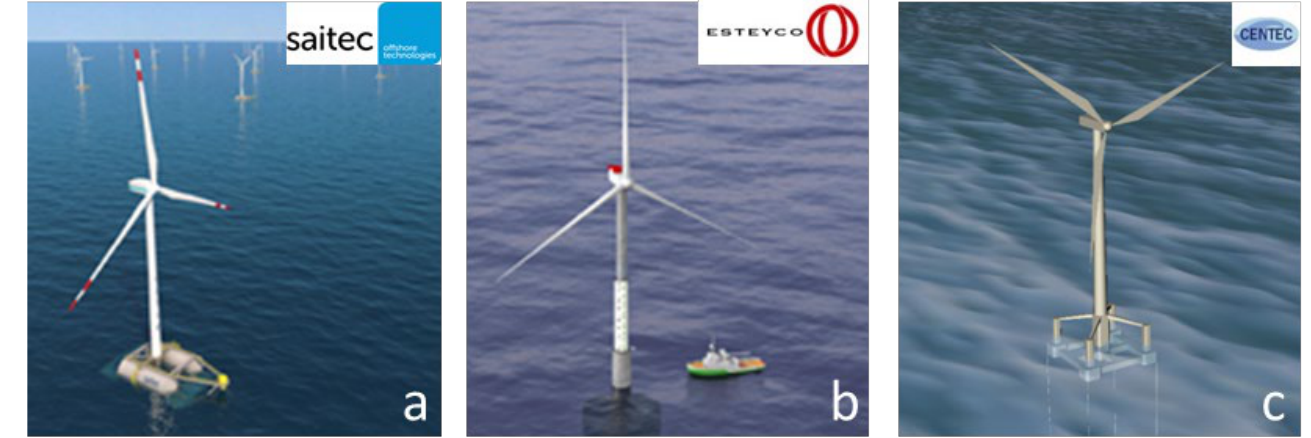
Figure 2. Floating wind platforms involved in the Arcwind project. ( a ) SATH ® platform concept (Semisub), ( b ) TELWIND ® platform concept (Spar), and ( c ) CENTEC-TLP platform concept (TLP).